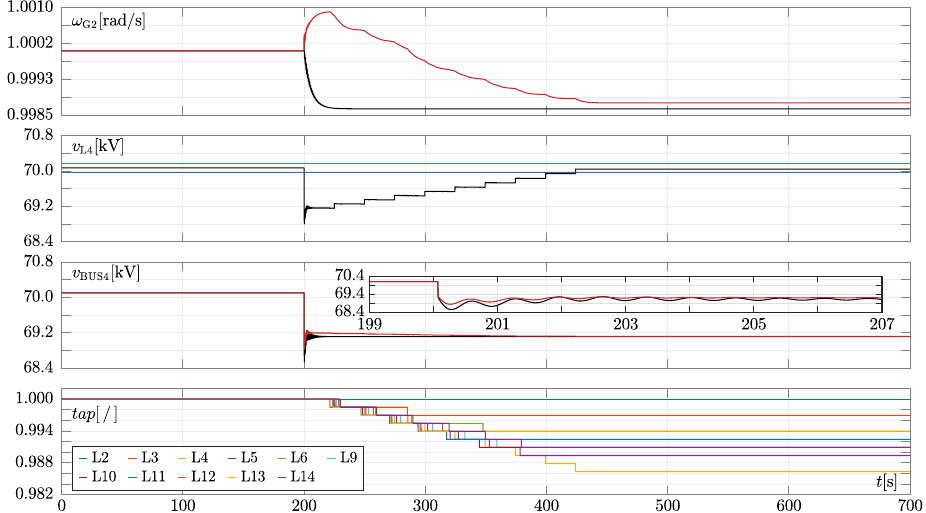
Figure 3. Simulation results of IEEE 14- P and IEEE 14- Z scenarios. Panels are described below from top to bottom. First panel: rotor angular speeds in [pu] of the G2 synchronous generator in the IEEE 14- P and IEEE 14- Z scenarios (black and red trace, respectively). Second panel: the black trace corresponds to the voltage magnitude of the constant impedance load L 4 when connected to BUS 4 through an OLTC in the IEEE 14- Z scenario, whereas the green and blue traces respectively depict the upper and lower edge of the voltage dead-band inside which the corresponding OLTC restores the load voltage. Third panel: voltage magnitude at BUS 4 in the IEEE 14- P (black trace) and IEEE 14- Z case studies (red trace). Fourth panel: the tap ratios of the OLTC s connected to each load in the IEEE 14- Z scenario. X-axis: time